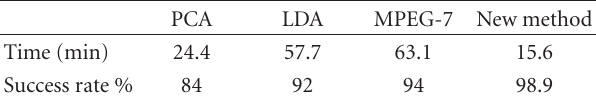
Table 13: The time consumed (in minutes) and the success recognition rate for the di ff erent methods using the FERET (Fb) database.